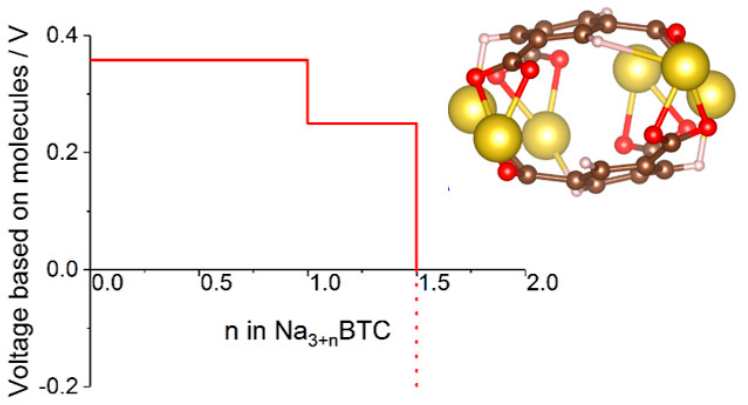
Figure 6. Voltage-capacity curve of sodium benzene tri carboxylate computed with a cluster model shown in the insert. See [47] for details.